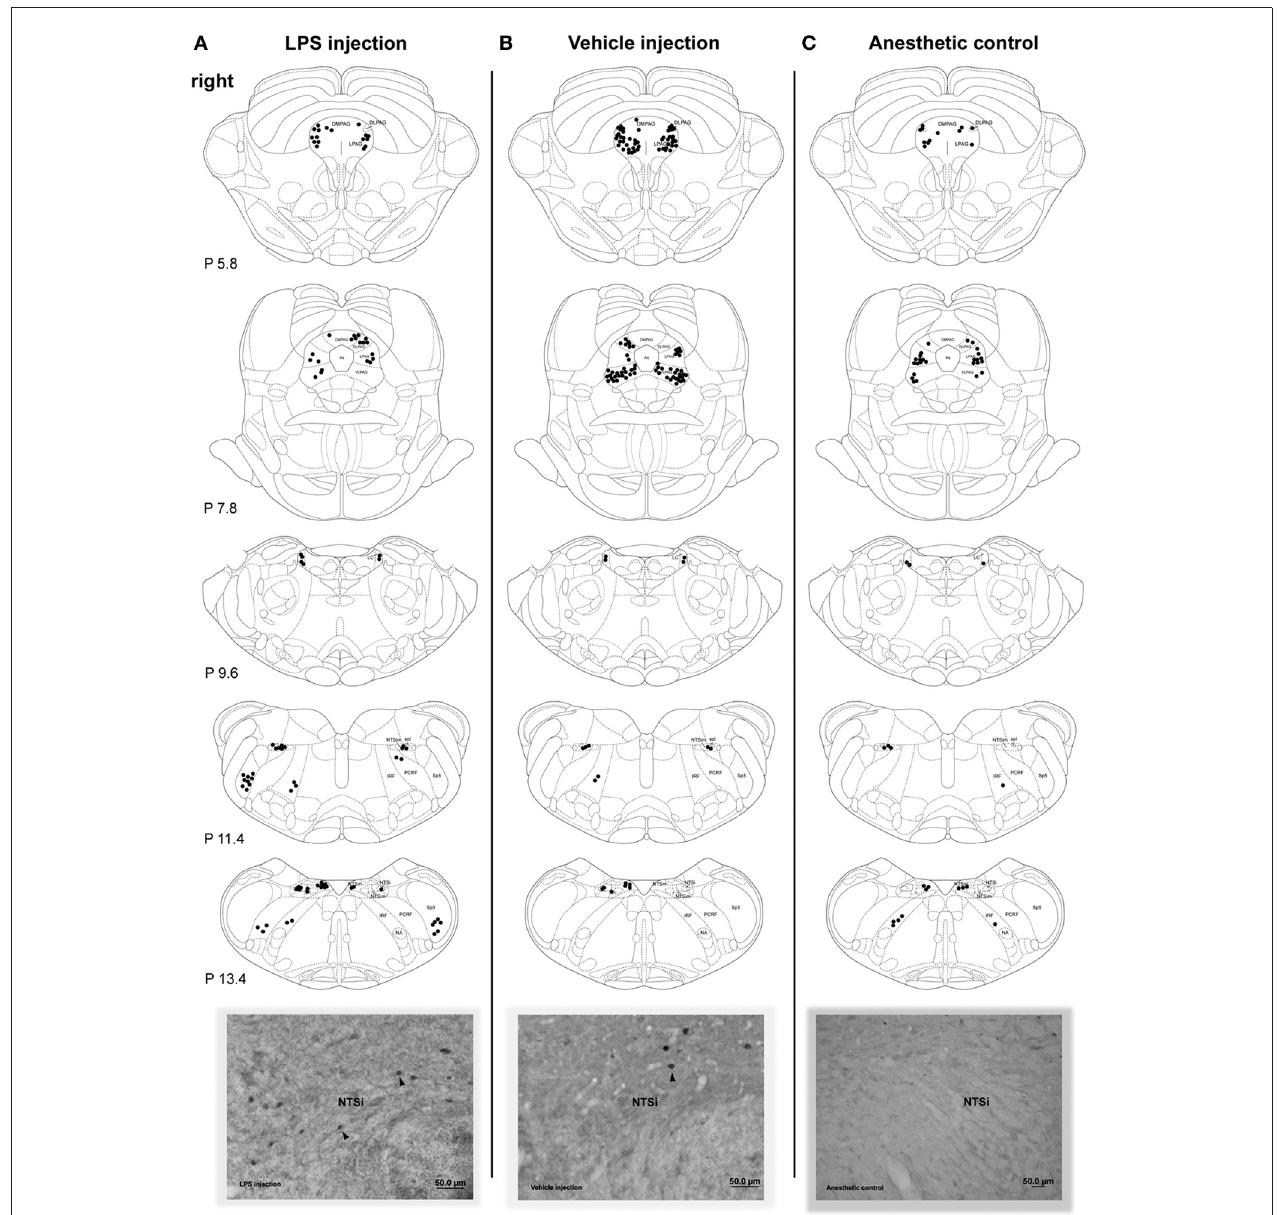
FIGURE 2 | Distribution of the Fos-positive neurons in the brainstem nuclei 72h after LPS (A) and vehicle (B) injections into the right vocal fold and in anesthetic control without any laryngeal manipulations (C). Schematic diagrams depict increased FLI in a single representative animal per respective group. Corresponding photomicrographs below the diagrams show Fos activation in the right NTSi (arrowheads mark Fos-positive nuclei). DLPAG, dorsolateral nucleus of the PAG; DMPAG, dorsomedial nucleus of the